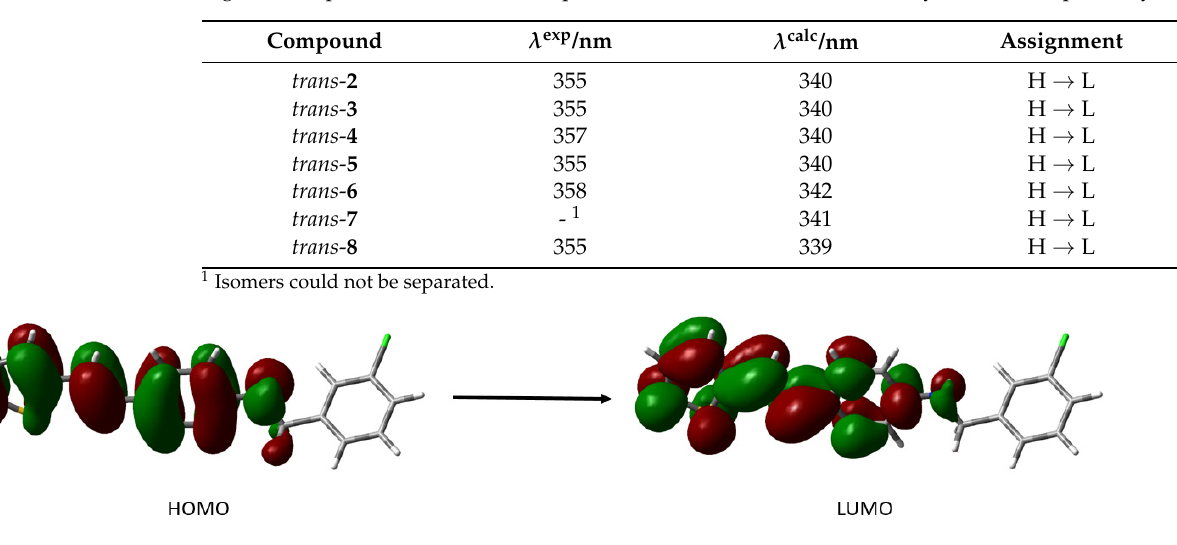
Figure 9. Canonical molecular orbitals involved in transition in UV-Vis spectra of compound trans - 5 .